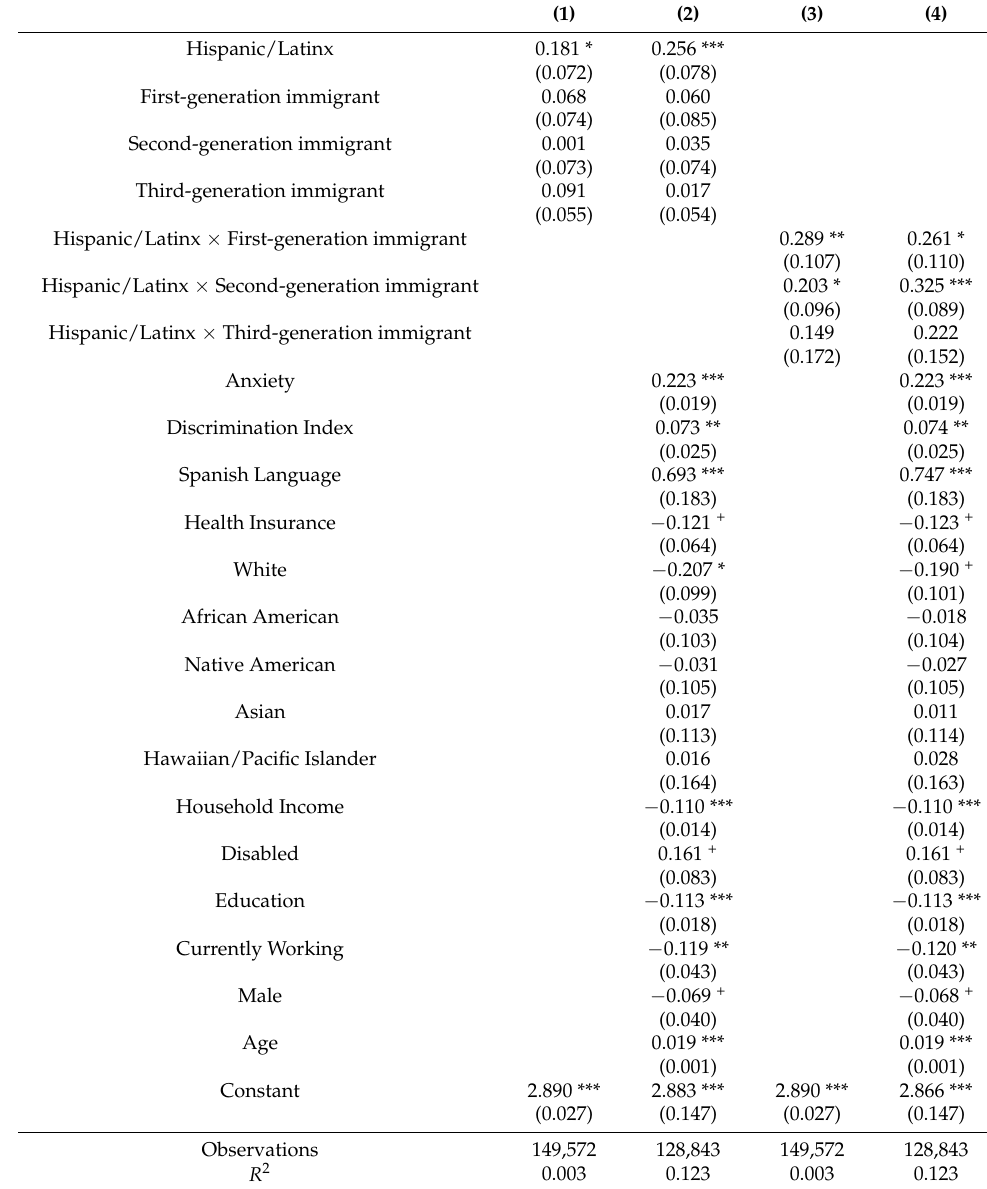
Table 4. Perceived Risk of